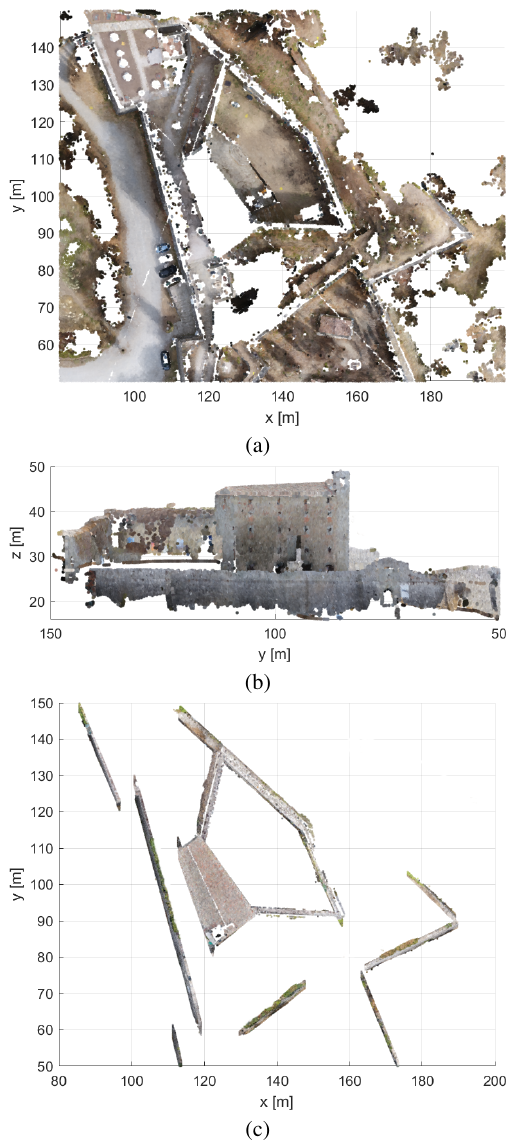
Figure 6. Points labeled as ground (a) and as part of the fortress (side view (b), and top view